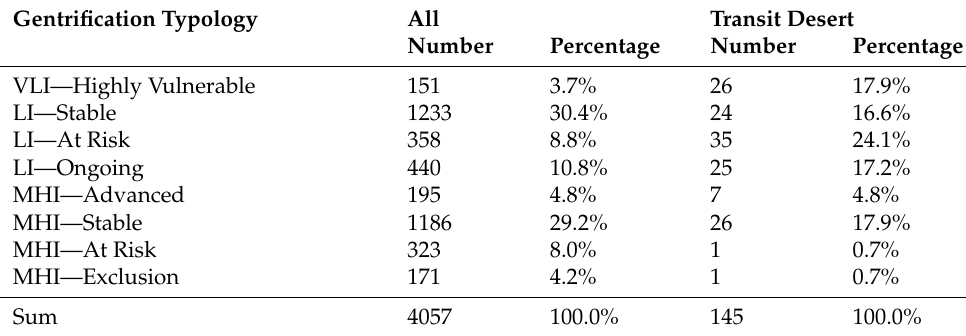
Table 3. Comparison between gentrification